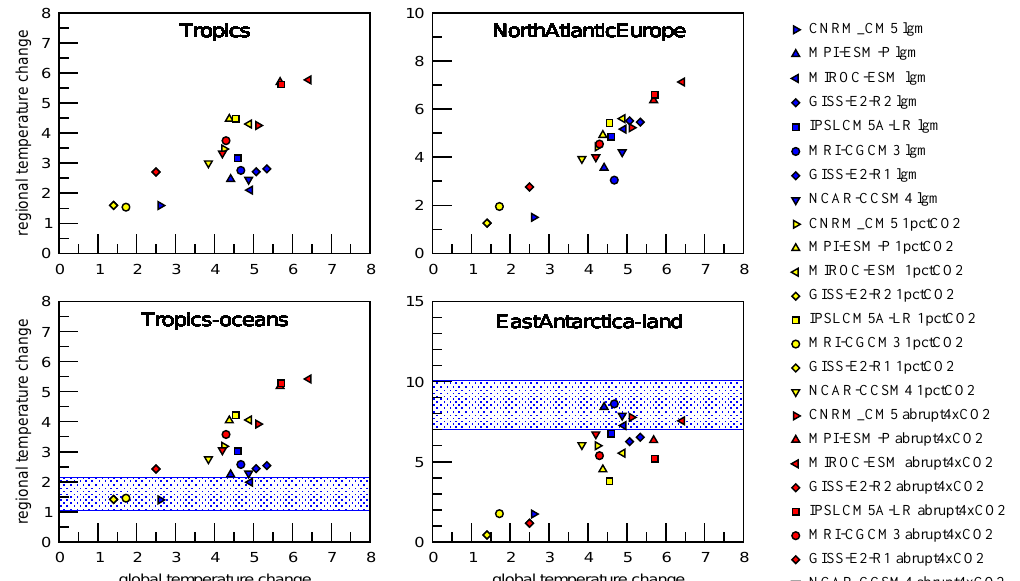
Fig. 1. Model average regional vs. global temperature changes for the glacial (in blue, the pre-industrial – LGM difference is shown), years 120 to 140 of the 1pctCO2 simulations (in yellow, in comparison to piControl) and years 100 to 150 of the abrupt4xCO2 simulations (in red, in comparison to piControl). For the bottom plots, the regional model average is taken only over grid boxes that correspond to proxy data sites within the defined region (reconstruction range shown in blue shading). For the tropical oceans (bottom-left panel), the blue shaded band shows the average ± 2 × standard deviations of the present – LGM warming as evaluated by the bootstrap method from the MARGO (2009) reconstructions, taking into account the uncertainty on the reconstructions (see main text). For East Antarctica, the blue shaded band corresponds to the range of available reconstructions (5 sites) ± 1 ◦ C (Braconnot et al., 2012). Definition of the regions: Tropics: 23 ◦ S–23 ◦ N; North Atlantic Europe: 45 ◦ W–90 ◦ E; 35–45 ◦ N; East Antarctica: 5 ◦ W–165 ◦ E; 70–80 ◦ S. The results have been computed for all models in the database on 23 July 2012 for which there were results for the lgm, piControl, 1pctCO2 and abrupt4xCO2